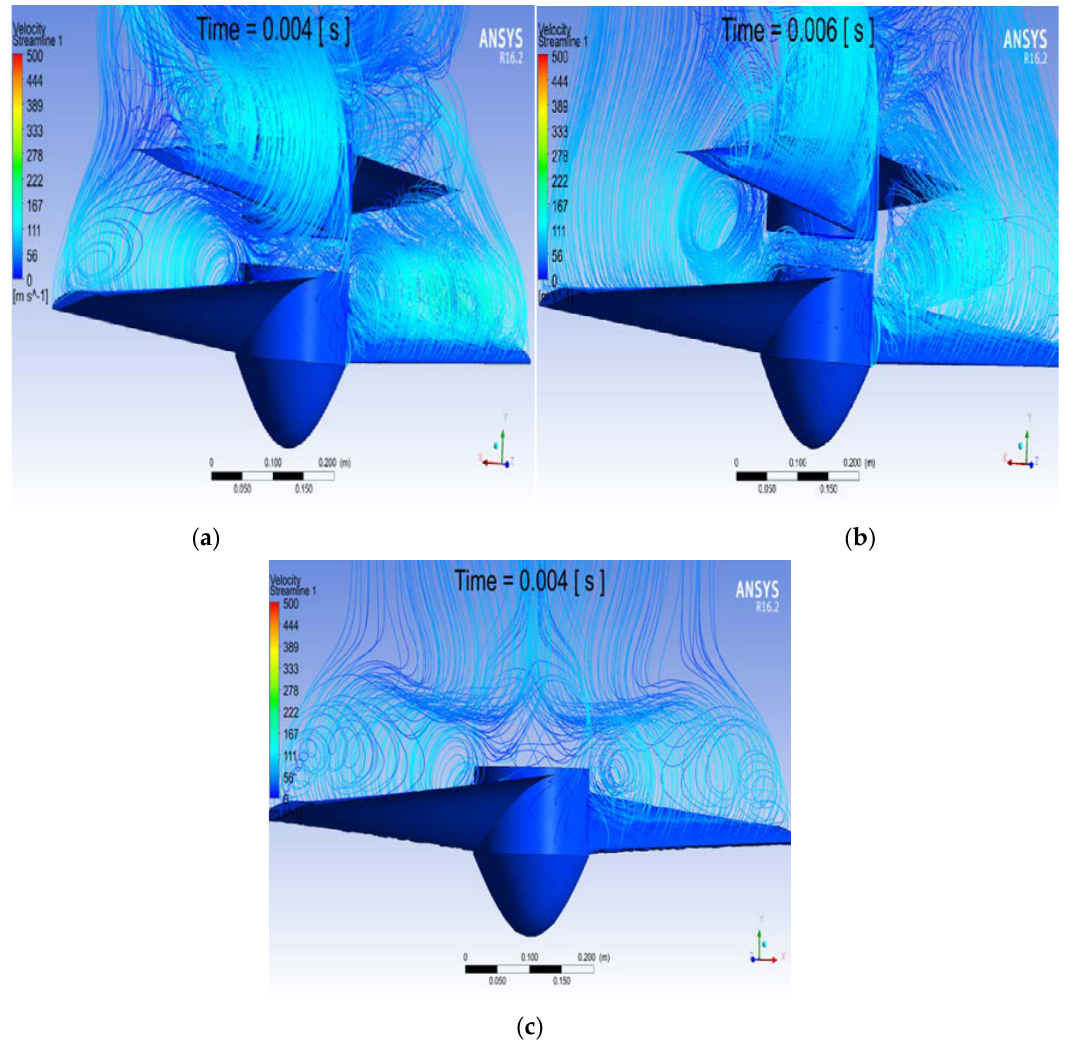
Figure 13. Velocity streamline ( a ) at time 0.004 s and at an axial distance of 14 cm, and ( b ) at time 0.006 s and at an axial distance of 14 cm; ( c ) single rotor.